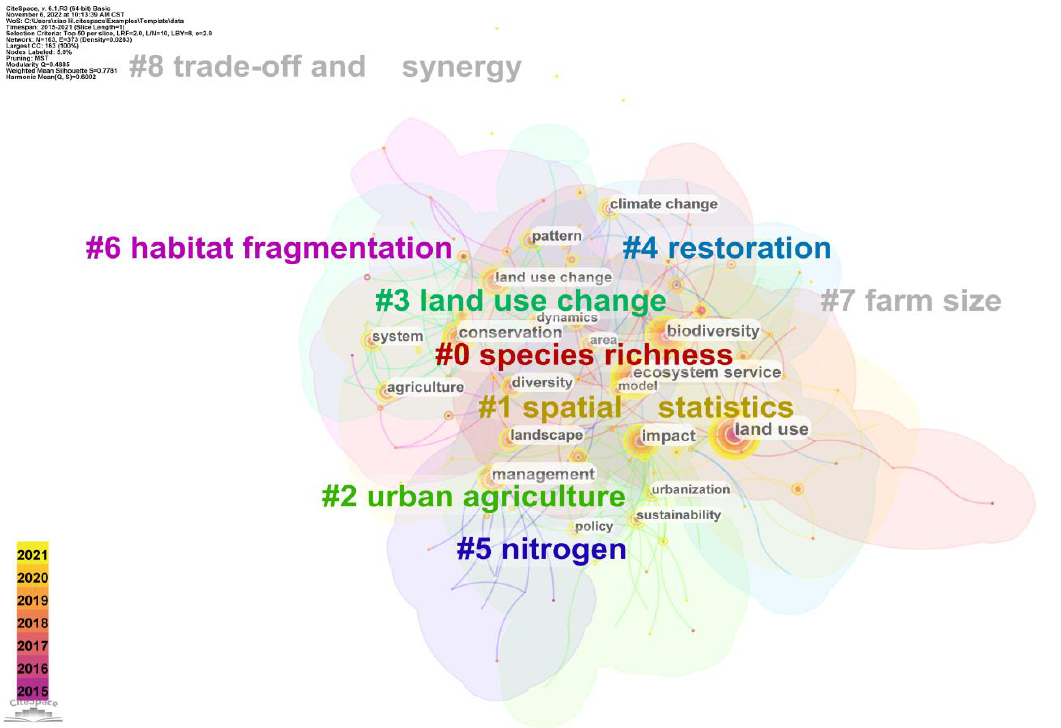
Figure 7. Cluster map of keywords of agricultural land function in the prosperity stage (the legend represents the color display for each year from 2015 to 2020).